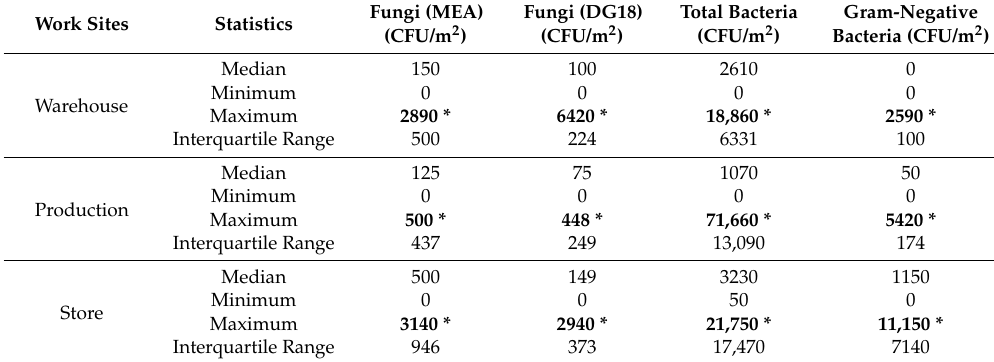
Table 4. Bioburden concentrations in the three different work sites assessed by